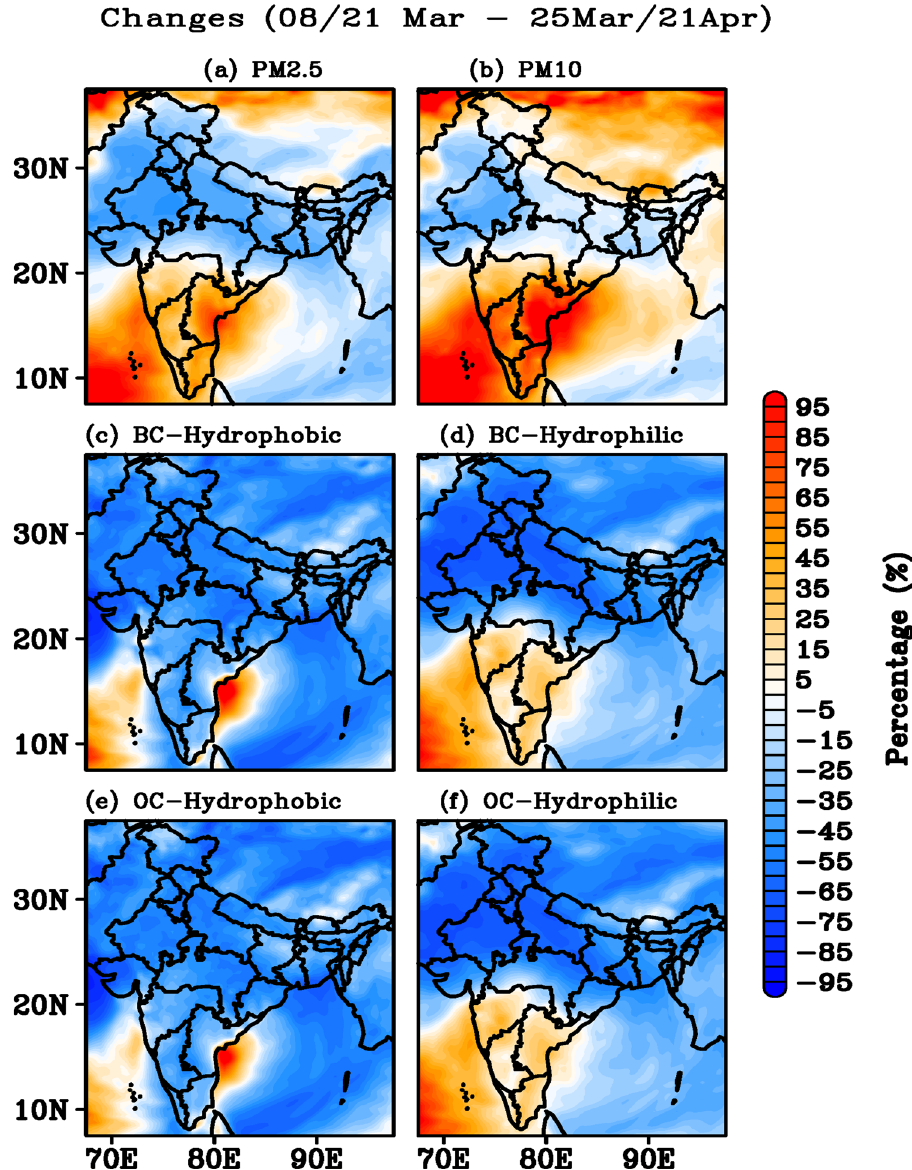
Figure 3. Percentage difference in the ( a ) PM 2.5 , ( b ) PM 10 , ( c ) BC hydrophobic, ( d ) BC hydrophilic, ( e ) OC hydrophobic, and ( f ) OC hydrophilic observed between the PLD and DLD periods based on WRF-Chem simulations for India and adjacent regions. The figures are plotted using GrADS V2.2.1 software (http:// cola. gmu. edu/